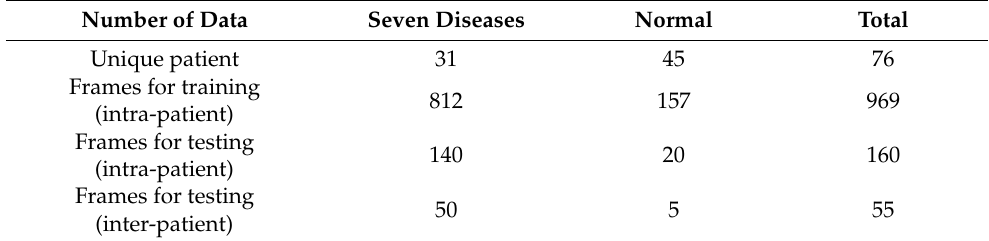
Table 1. Distribution of patients and clean cardiac frames.